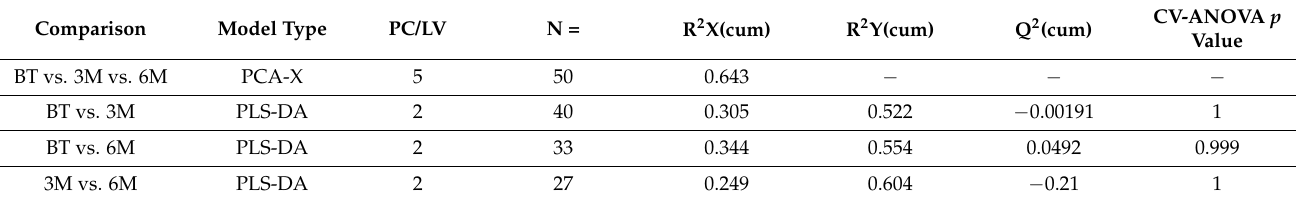
Figure 4. Boxplots for metabolites with VIP scores above 1.00 and statistical importance after p value adjustment ( q < 0.05). Red bars—AS patients before treatment; blue bars—3 months after initialization of anti-TNF treatment; green bars—6 months after treatment with TNFi. Whiskers—1.5 × interquartile range (IQR); bar—average; box—range between first quartile (Q1) and third quartile (Q3). Green line—average positive response for treatment; yellow line—average neutral response for treatment. Pink circle—data point for before treatment; red circle—data point for no information about response; green circle—data point for positive response for treatment; yellow circle—neutral response for treatment. * q value < 0.05 (precise values in Table S3). Table 3. The multivariate analysis models summary for PsA patients’ treatment